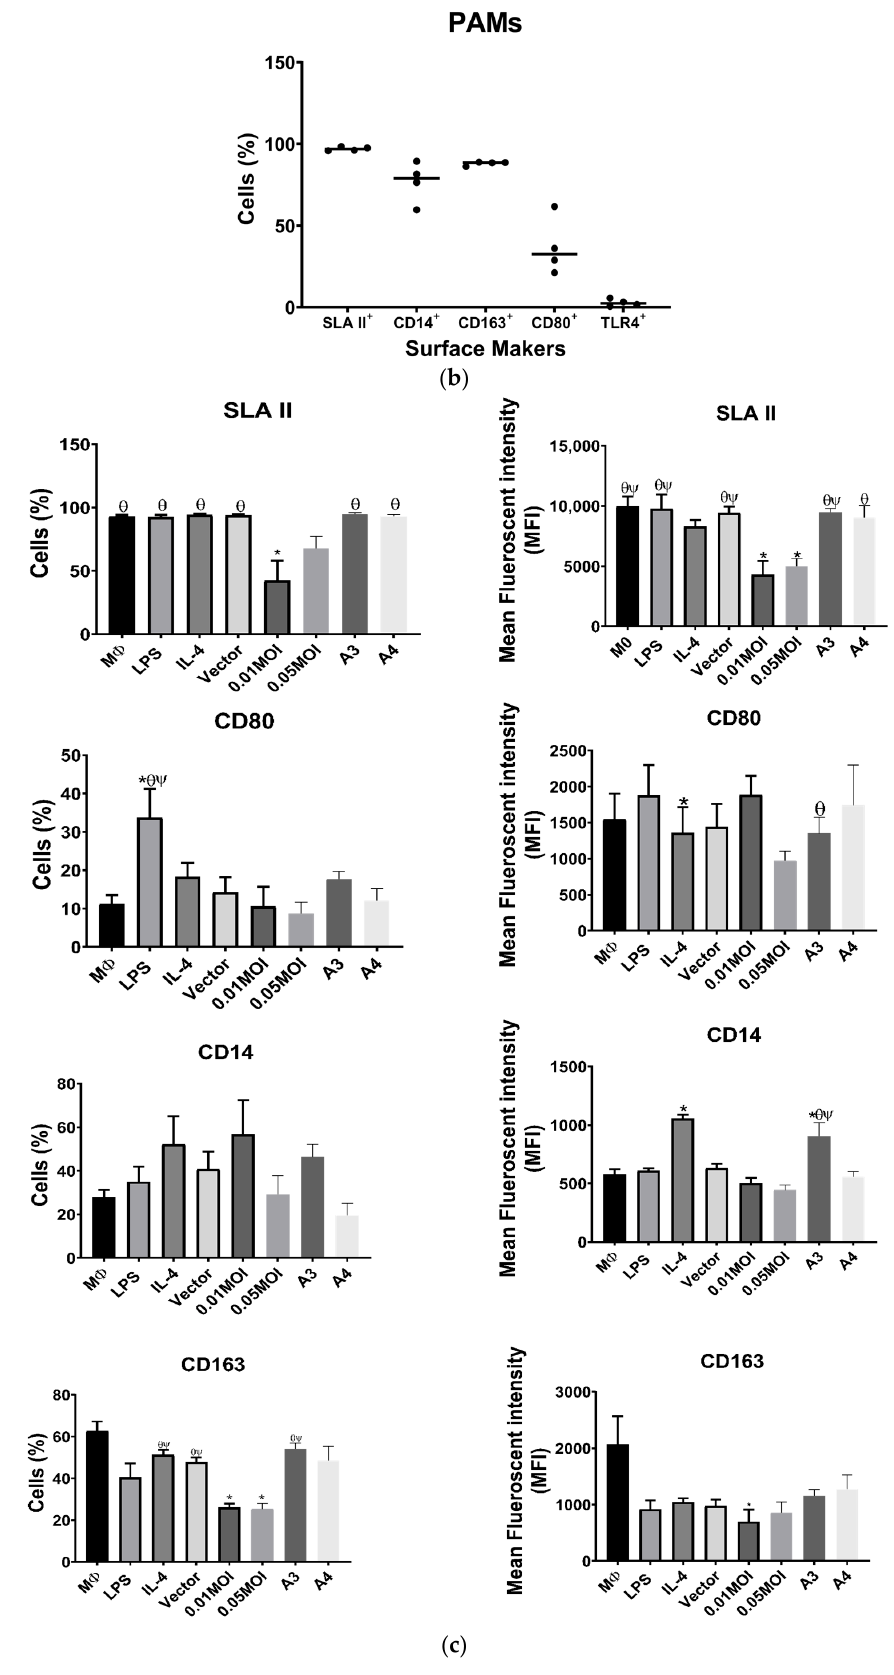
Figure 1. Fresh isolated PAMs expressed high levels of CD163 and susceptible for PRRSV